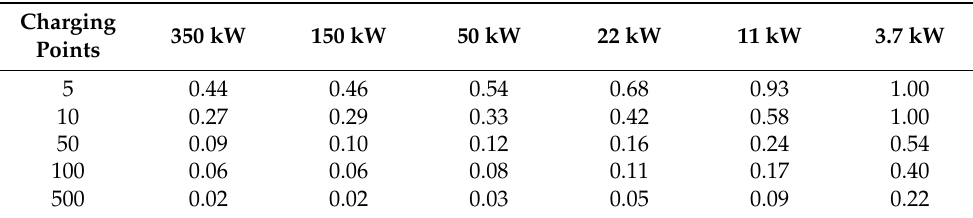
Table A2. Demand factors for the area type “Urban Region: Regiopolis, Large City” and six charging powers.